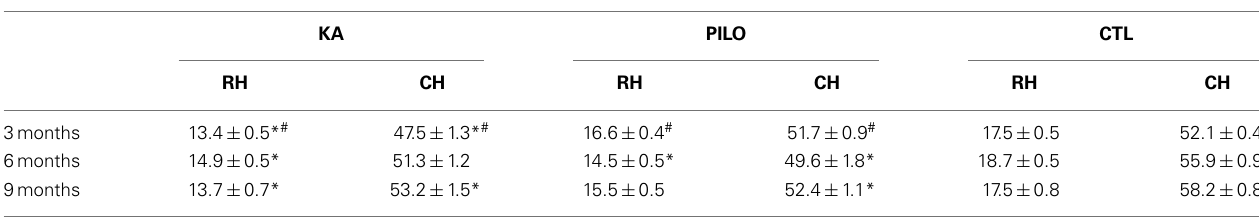
Table 1 | Hippocampal MRI volumetry . KA PILO